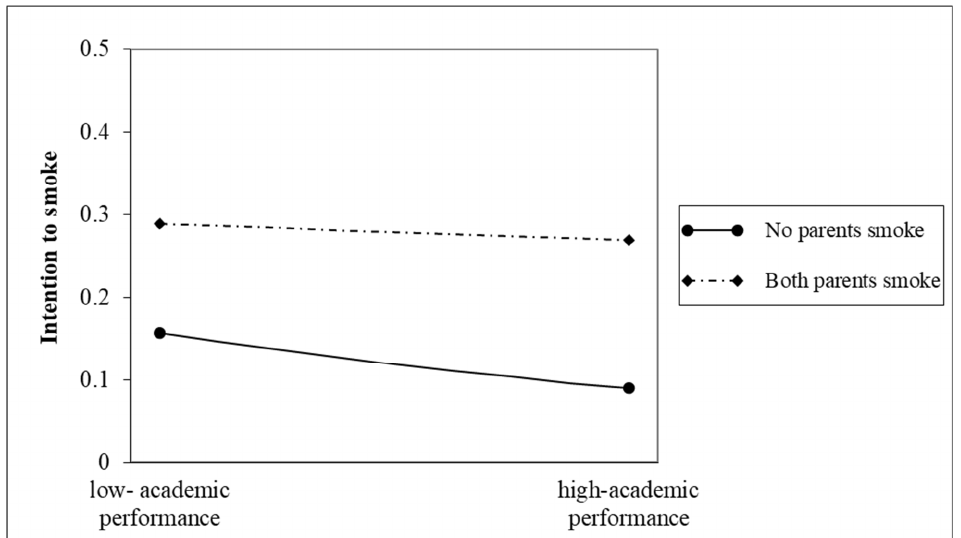
Figure 2. Interaction between academic performance and parents’ smoking and intention to smoke among non-smoking students. among non-smoking